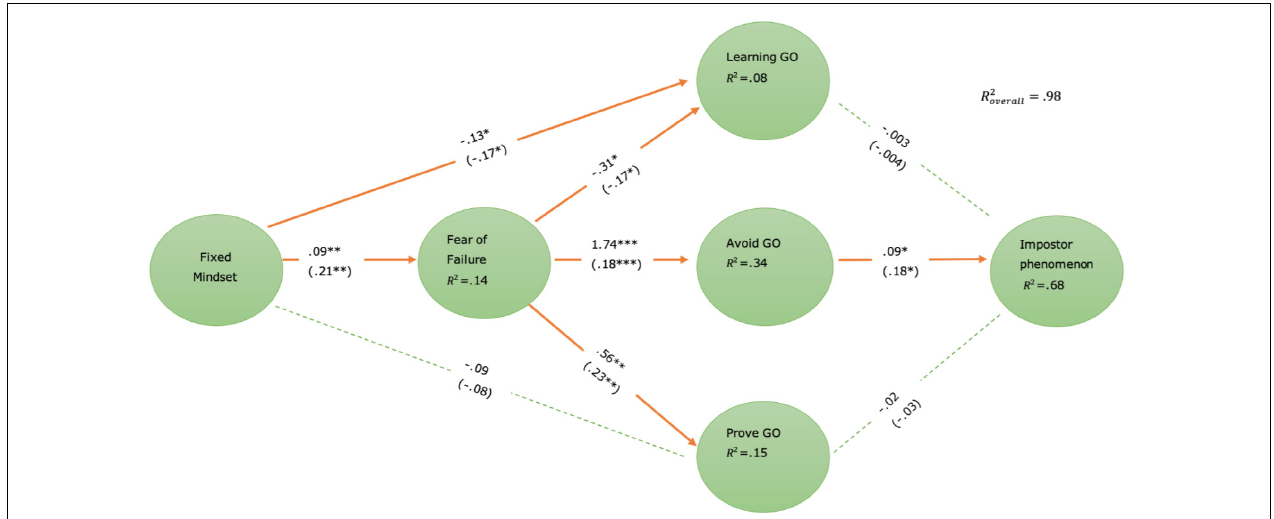
FIGURE 2 | Direct effects of the serial-parallel SEM Model (standardized coefficients in parentheses). Dashed line represents non-significant effects. ∗ p < 0.05, ∗∗ p < 0.01, ∗∗∗ p < 0.001 (one tailed).